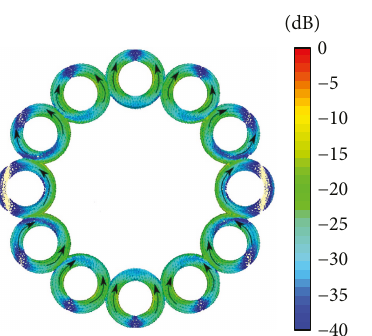
Figure 8: Surface current of the proposed lens antenna at 10 GHz.